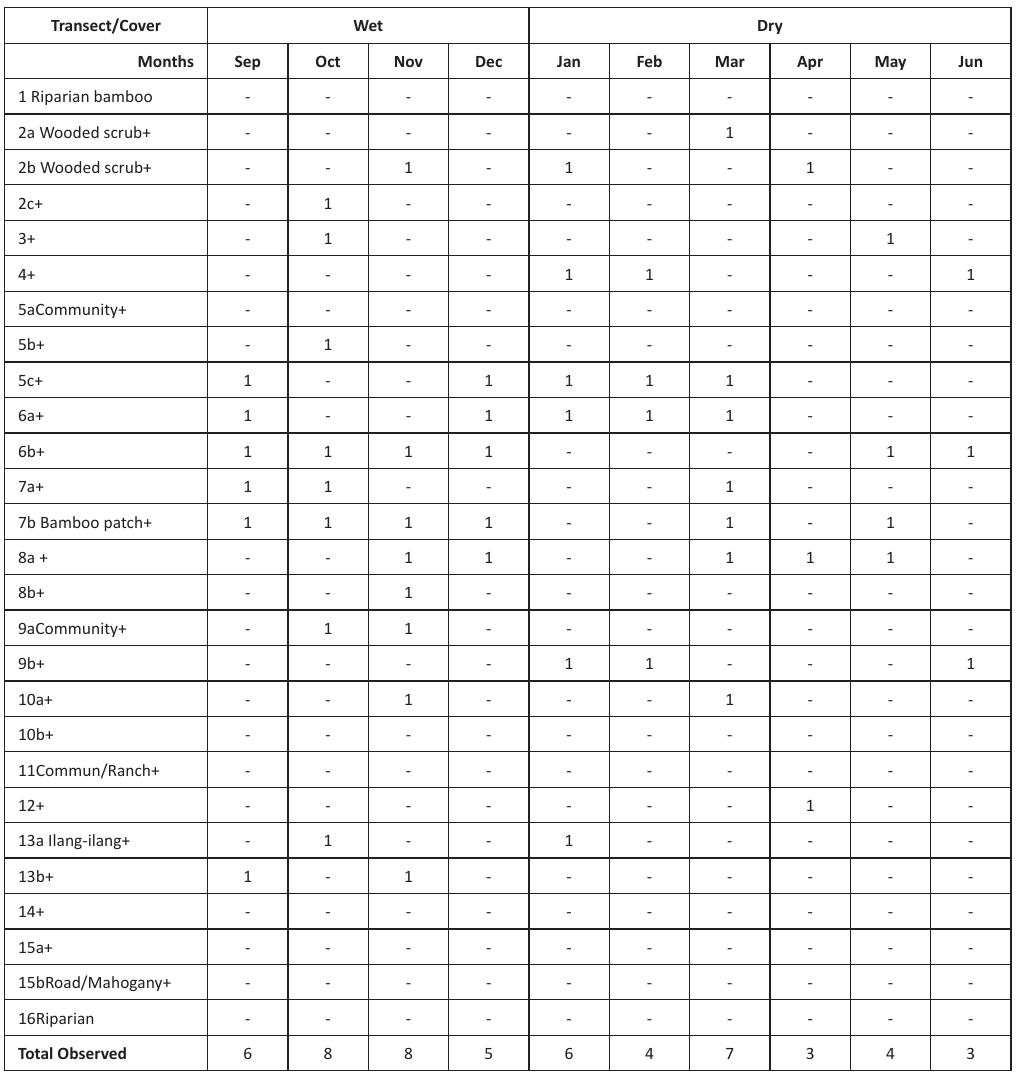
Table 2. Spoor observed per transect divided according to climatic seasons.